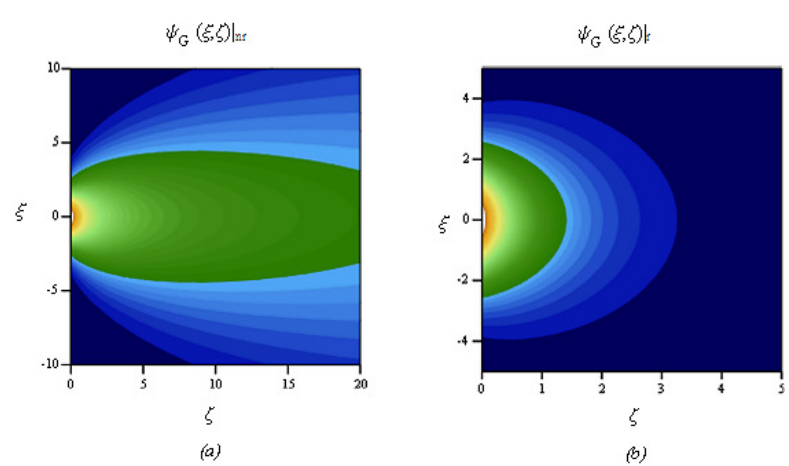
Figure 5. ( ζ , ξ ) -contourplots exemplifyng the ( a ) “non-relativistic” and ( b ) “relativistic”